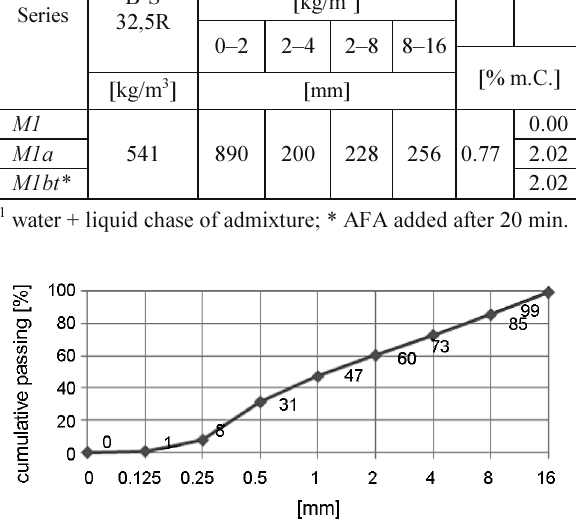
Fig. 7. Curve of aggregate grading